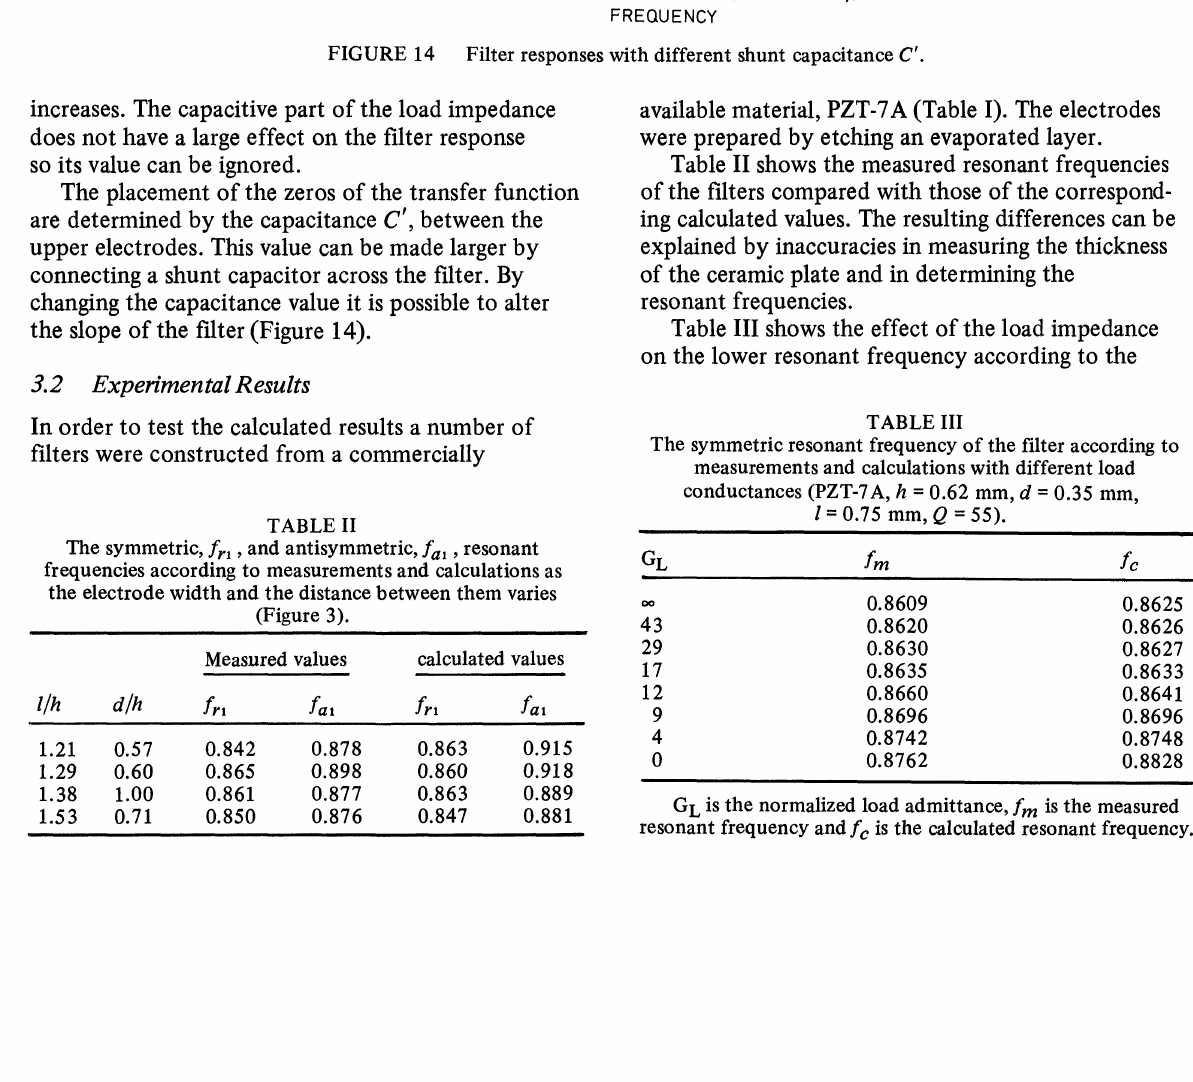
FIGURE 14 Filter responses with different shunt capacitance C’.